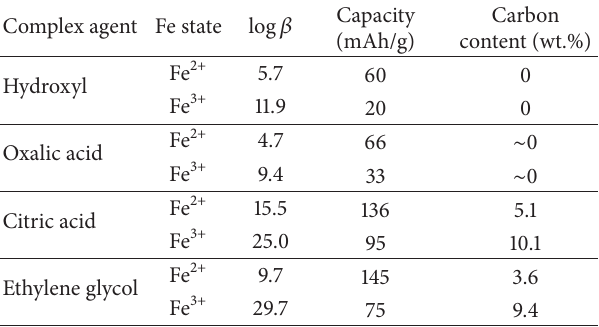
Table 2: Comparison of reversible capacity, carbon content in LiFePO 4 /C products, and the complex stability constants (log 𝛽 ) between chelating agents with iron